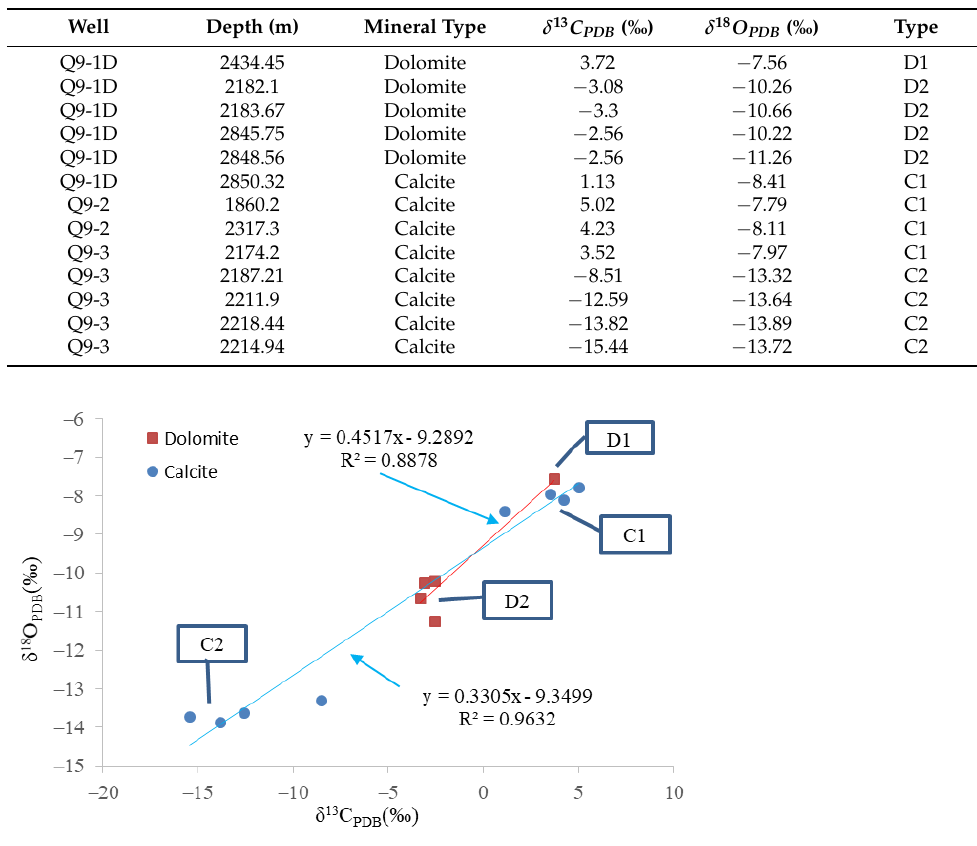
Figure 5. The distribution of the isotope of carbonate minerals; D1, D2, C1, and C2 represent early dolomite, ferrodolomite, ferrocalcite, and late calcite, respectively .